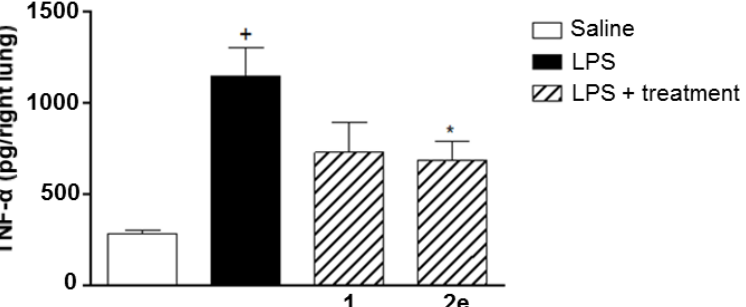
Figure 4. Effect of the phthalimide derivatives 1 and 2e (50 mg/kg; p.o.) on tissue TNF- α production in a murine model of acute lung inflammation induced by LPS (25 μ g/animal, i.n.). Values are mean ± SEM from six animals. + p < 0.05 as compared with saline group; * p < 0.05 as compared with the group stimulated with LPS; ANOVA followed by Newman-Keuls Student test.